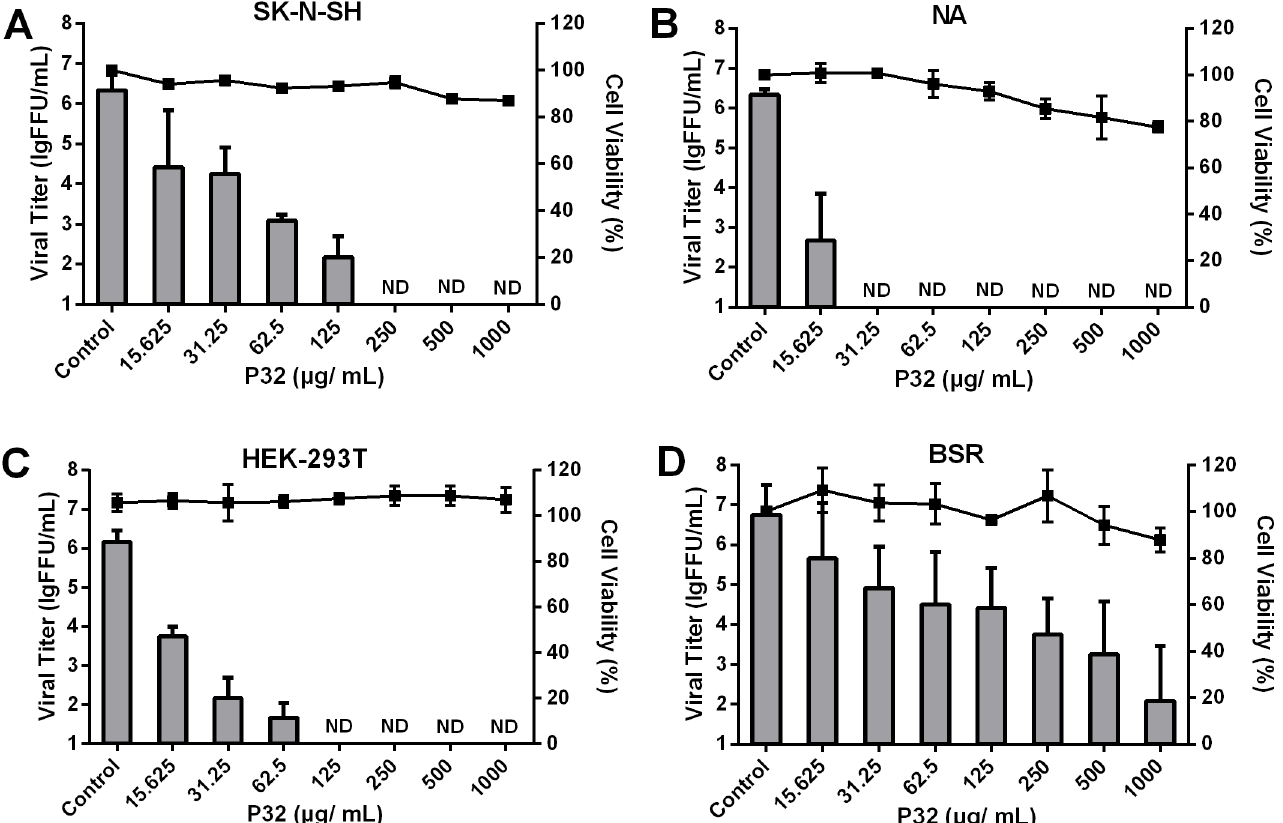
Fig 2. Cytotoxicity and RABV inhibitory effect of P32 on different cell lines. To assess the cytotoxicity of P32 in different cell lines, we used the MTS method. SK-N-SH (A), NA (B), HEK-293T (C), and BSR cells (D) were incubated with different concentration of P32 for 48 h at 37°C, after which the cells were incubated with MTS solution for 1 h. Absorbance at 490 nm was determined, and the percent cell viability for each P32 treatment group was determined by comparing the treated cells with mock-treated cells. For the inhibition assay, cells were infected with SAD-L16-eGFP at an MOI of 0.01 after a 2-h incubation with P32. Supernatants were harvested for virus titration at 48 hpi. Columns and black solid squares represent the viral titers and the cell viability percentages, respectively. Each value is expressed as the mean ± SEM from three independent experiments. ND means non-detectable.